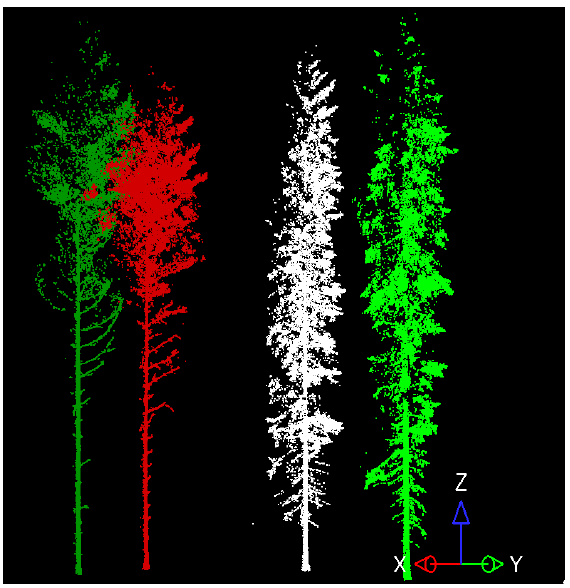
Figure 2: TLS point clouds from Scots pines (left) and Norway spruces (right).